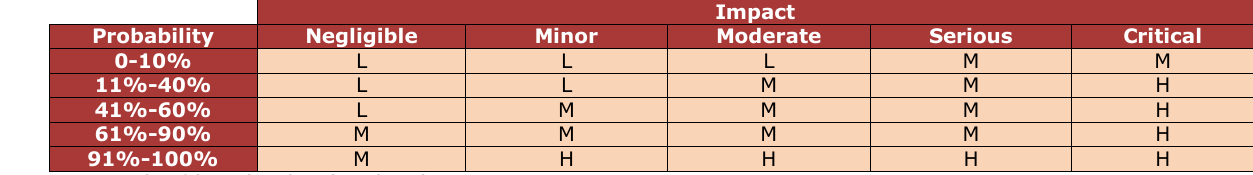
Table 4. Level -Impact- Probability of the risk